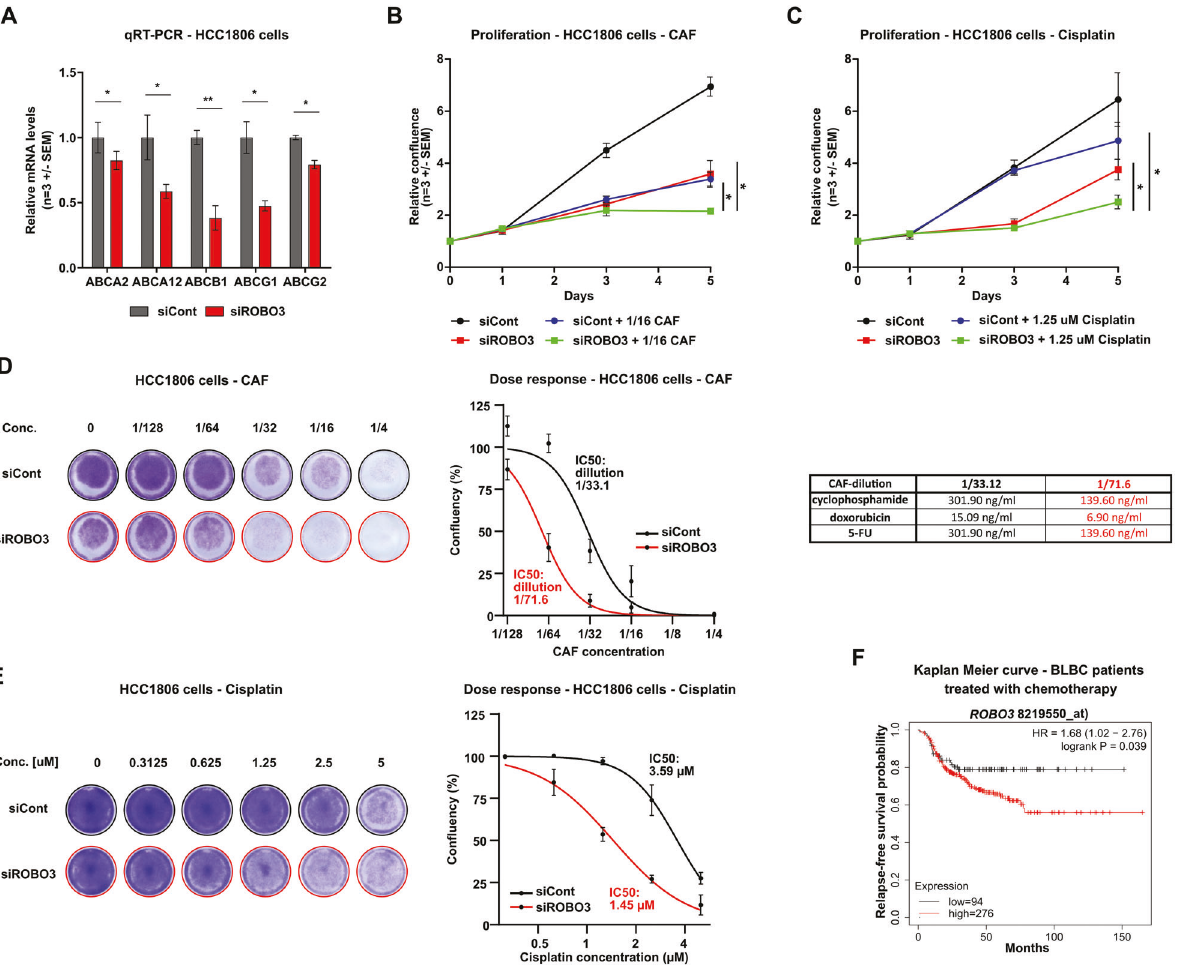
Fig. 6 ROBO3s loss sensitizes BLBC cells to chemotherapy. A qRT-PCR of several ABC transporter genes upon ROBO3 knockdown or siRNA control treatment of HCC1806. B Proliferation assay of HCC1806 cells, treated with siROBO3, 1:16 CAF or in combination. C Proliferation assay of HCC1806 cells, treated with siROBO3, 1.25 μΜ cisplatin or a combination. Relative con fl uency was measured by Celigo ® and normalized to day 0. Statistical analyses were performed on the AUC. D , E Dose response assay of siCont or siROBO3 treated HCC1806 cells and increasing doses of CAF or cisplatin. F Patient survival analysis for ROBO3 low and ROBO3 high -expressing BLBC patients treated with chemotherapy (source: kmplot.com). A , B , C , D and E : Error bars represent mean ± SEM of three biological replicates, unpaired t-test. * p < 0.05; ** p < 0.01; *** p <